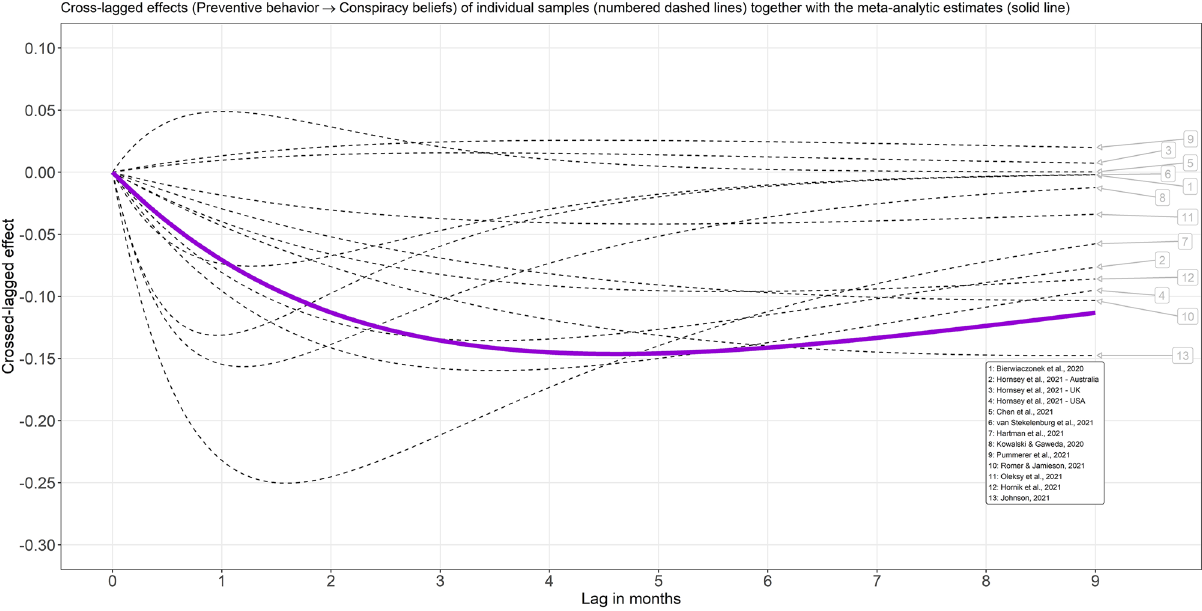
Figure 3. Model-implied cross-lagged effects (preventive behavior → conspiracy beliefs) for a range of time lags in months. On average, data for approximately 3 to 4 months were available. Thus, parts of the individual trajectories are simple extrapolations. For short studies, such as 1 and 8, the cross effects at large time lags cannot be reliably estimated. Hence, the largest effects in short studies are shifted to shorter time lags than the meta-analytic